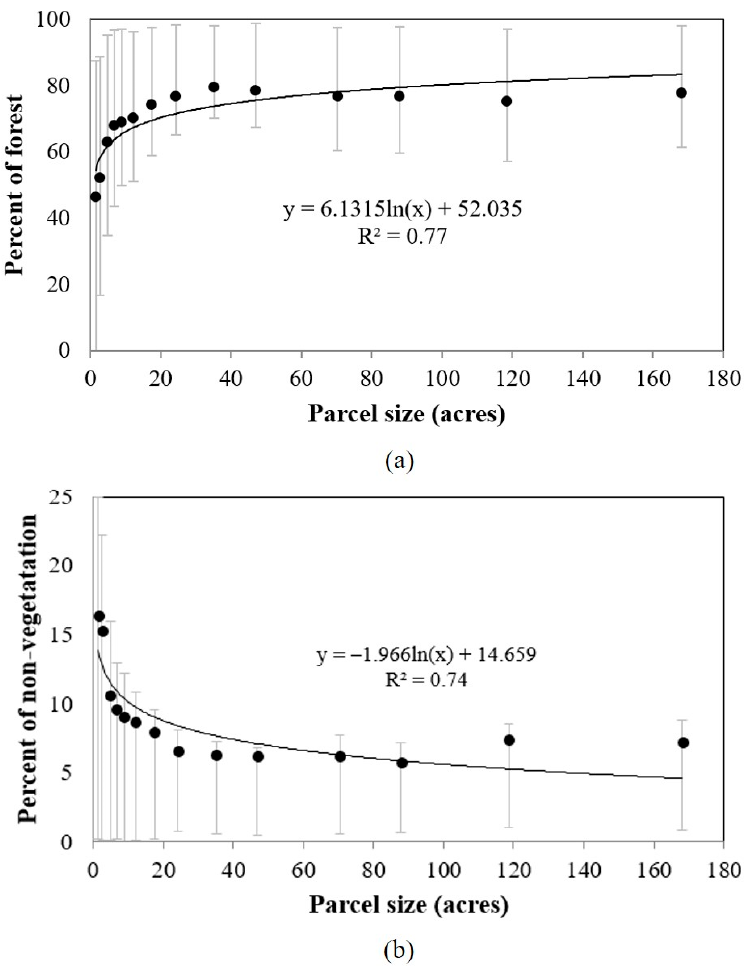
Figure 9. Percentage of forest versus parcel size ( a ) and percentage of non-vegetation (e.g., urban, bare land, and water) versus parcel size; ( b ). The black point is mean value of each bin, the error bar is the 0.25-0.75 percentiles, and the solid line is the regression line.